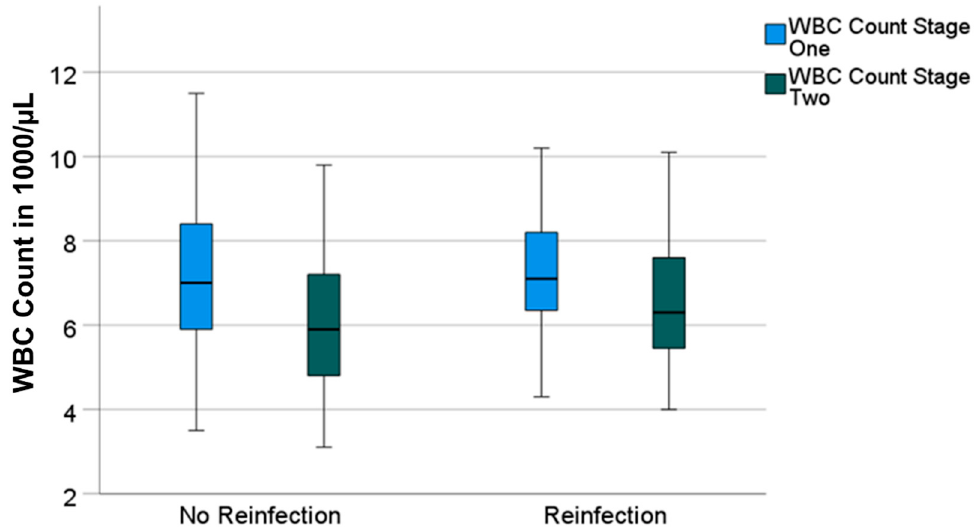
Figure 2. Boxplots for white blood cell count (“WBC count“) values prior to stage-one and prior to stage-two surgeries, divided in groups without and with reinfection.